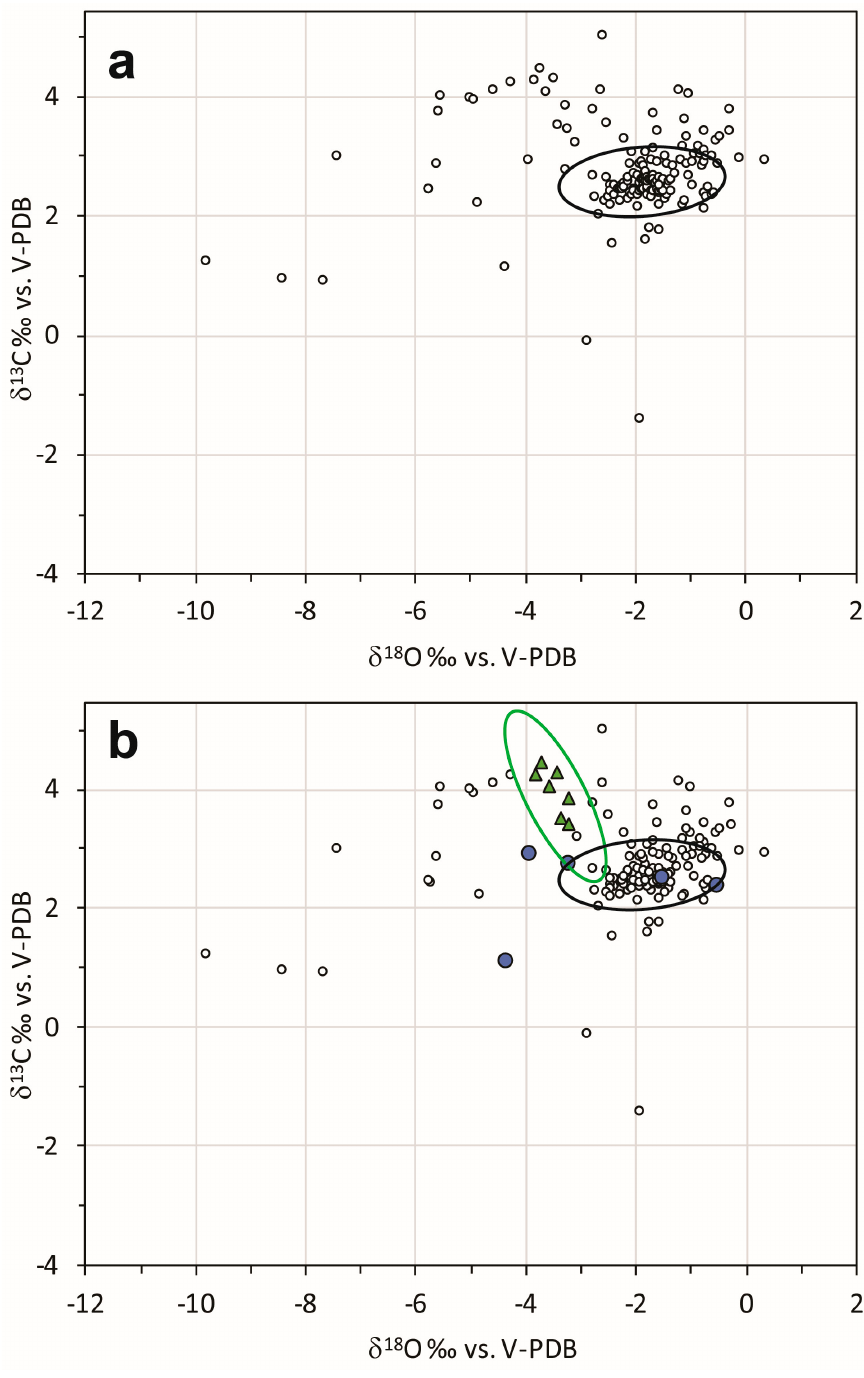
Figure 2. Stable isotope scatterplots of the marbles from Aléria; ( a ) the open circles represent the totality of the samples analyzed from the inscriptions, the Carrara 99% probability ellipse is drawn according to indications of [36] (data markers that define the Carrara ellipse are not shown); ( b ) the green triangles represent the samples macroscopically attributed to greco scritto (enclosed in a 95% probability ellipse); colored stones are also indicated with a blue circle marker; the Carrara 99% probability ellipse is drawn as in ( a ).